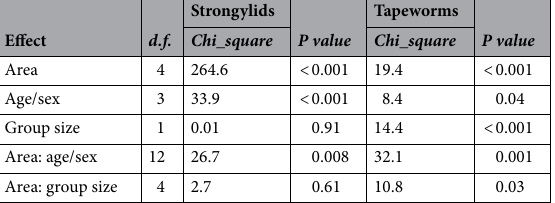
Table 2. Factors influencing helminth infections in Virunga Massif and Bwindi Impenetrable National Park (dataset 1: nest samples from all national parks).